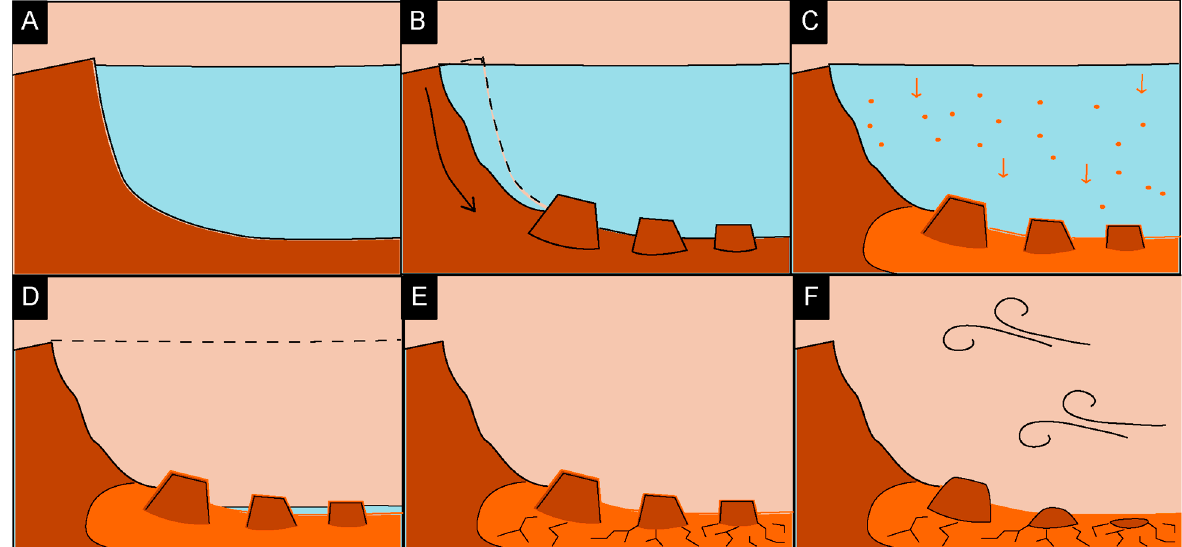
Figure 10. Schematic interpretation of the depositional history in Galilaei crater. ( A ) Galilaei crater hosts a paleolake with water levels near the crater rim before the development of any outflow channel. ( B ) Gravity-driven slope failures along the crater walls deposit slide blocks in the crater interior. ( C ) Pelagic sedimentation deposits flat-lying strata across the crater floor. ( D ) An outflow channel (Tana Vallis) is carved into the rim of Galilaei crater, causing it to rapidly drain. Some water remains in the lowest elevation regions in the center of the crater. ( E ) The remaining water evaporates from Galilaei crater, leaving polygonal desiccation patterns on the surface. ( F ) More than 1 billion years of intervening erosion degrade the surface expression of the blocks, causing some to round or be entirely winnowed away, leaving some pits in the lake deposits and leading to the morphologies observed today.